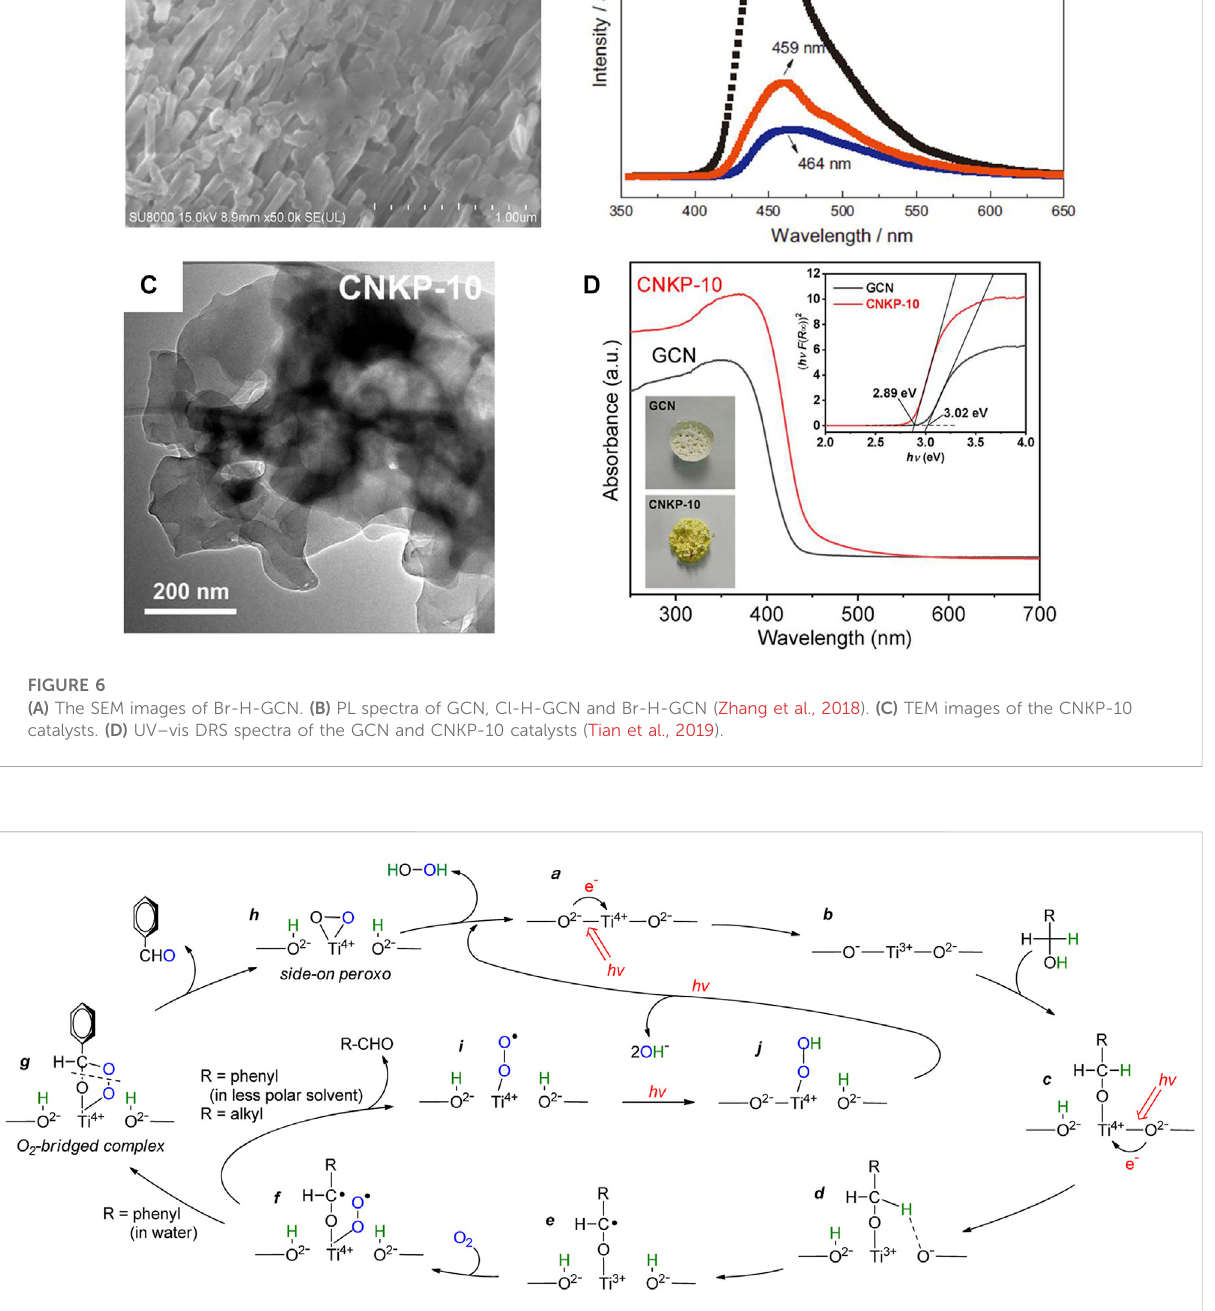
FIGURE 7 Proposed mechanism for photocatalytic oxidation of alcohols with O 2 on the TiO 2 Surface (Shiraishi et al., 2013).